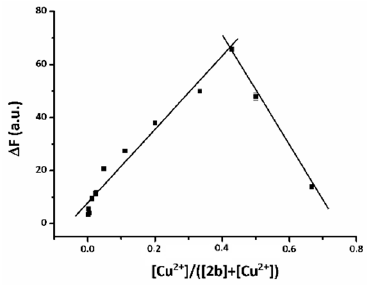
Figure 7. Job plot based on the fluorescence titration of 2b (30 μ M) with Cu 2+ .